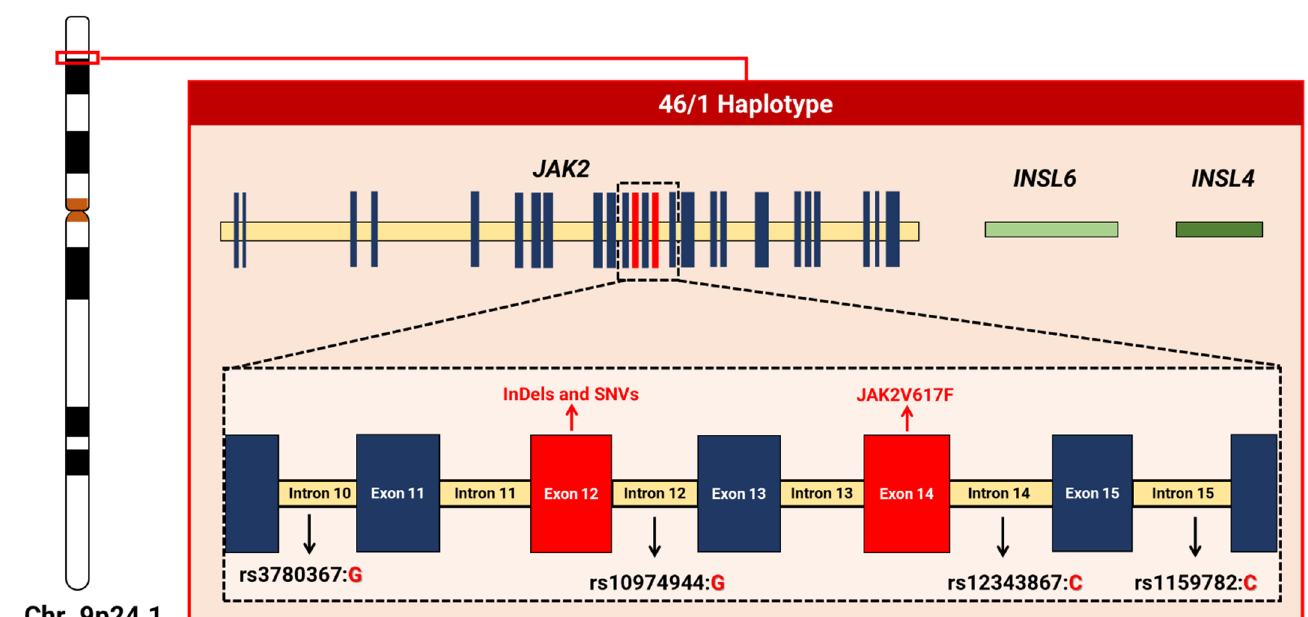
Figure 2. Schematic representation of the 46/1 haplotype based on the JAK2 gene reference se- quence (NG_009904). The haplotype extends over a block with approximately 250–280 kb on chromosome 9p, and encompasses three genes ( JAK2 , INSL6 , and INSL4 ) and regions with a high rate of genetic variants in JAK2, such as exon 12 (with alterations such as insertions, deletions, and substitutions) and exon 14 (location of JAK2V617F). Four variants (rs3780367, rs10974944, rs12343867, and rs1159782) mark the haplotype and establish another nomenclature based on the variant alleles, GGCC, as also mentioned in the literature [97] .